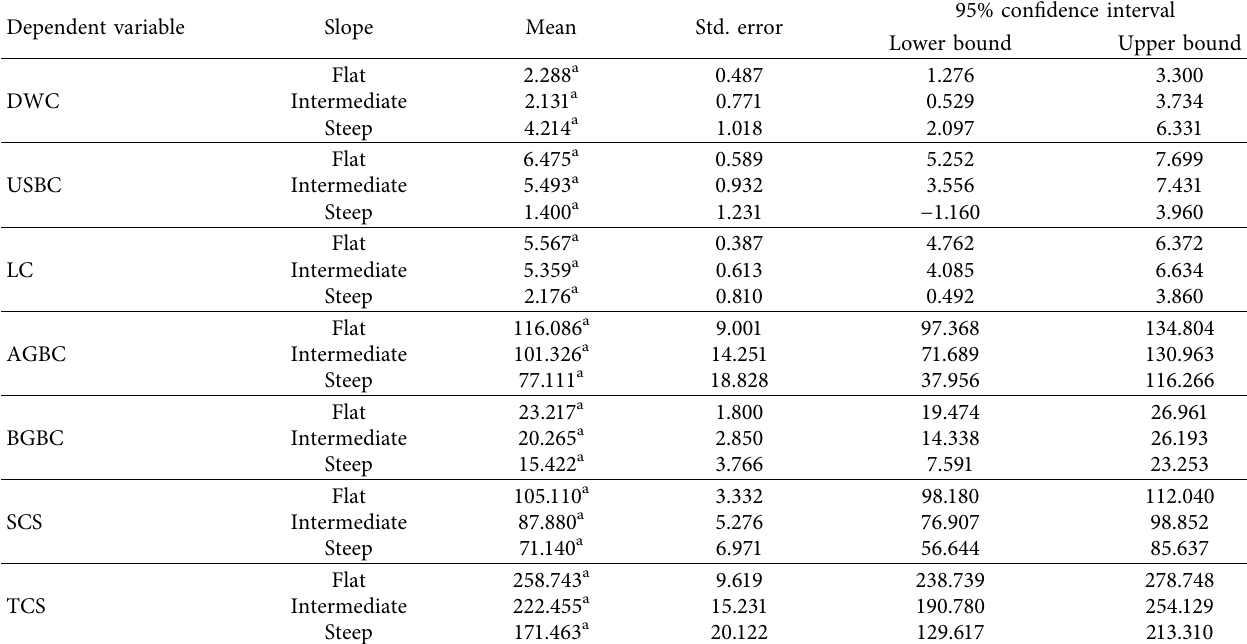
Table 12: Estimated marginal means of slope in Ziba